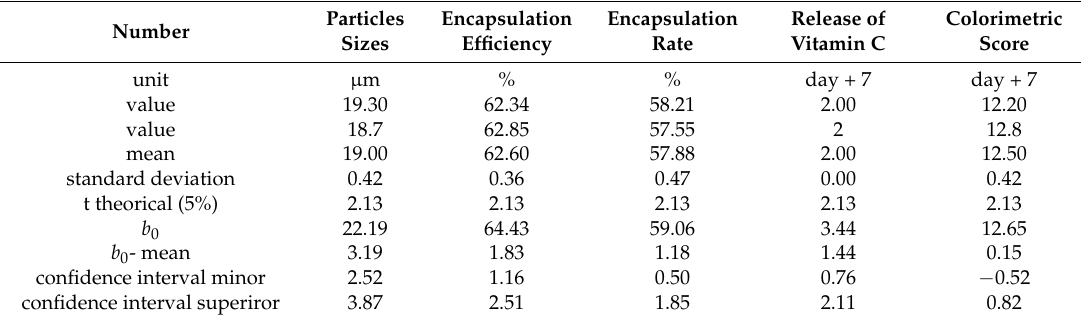
Table 4. Confidence interval.